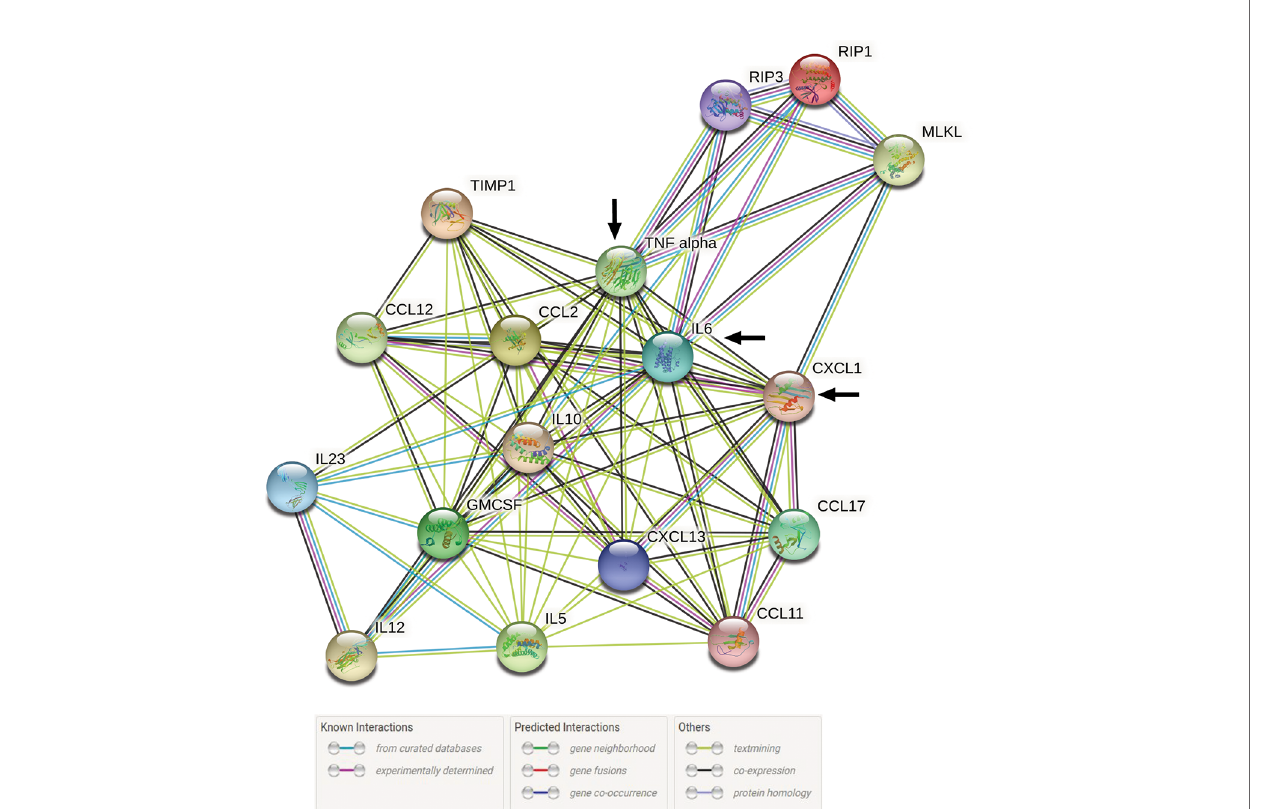
FIGURE 7 | STRING proteome analysis of chemo-cytokines with major necroptosis molecules at 72h post infection. A total of 17 proteins (14 elevated chemokines and cytokines in serum of infected mice (2) and 3 elevated necroptotic proteins in spleen) were analyzed by protein network analysis using STRING online database (string-db.org) tools. Representative protein-protein network model is representative of total number of Nodes = 17 and Edges = 84 with medium level of con fi dence (0.400). Black arrow indicates the direct interaction between IL-6, TNF- a and CXCL1/KC with necroptotic molecules MLKL, RIP1 and